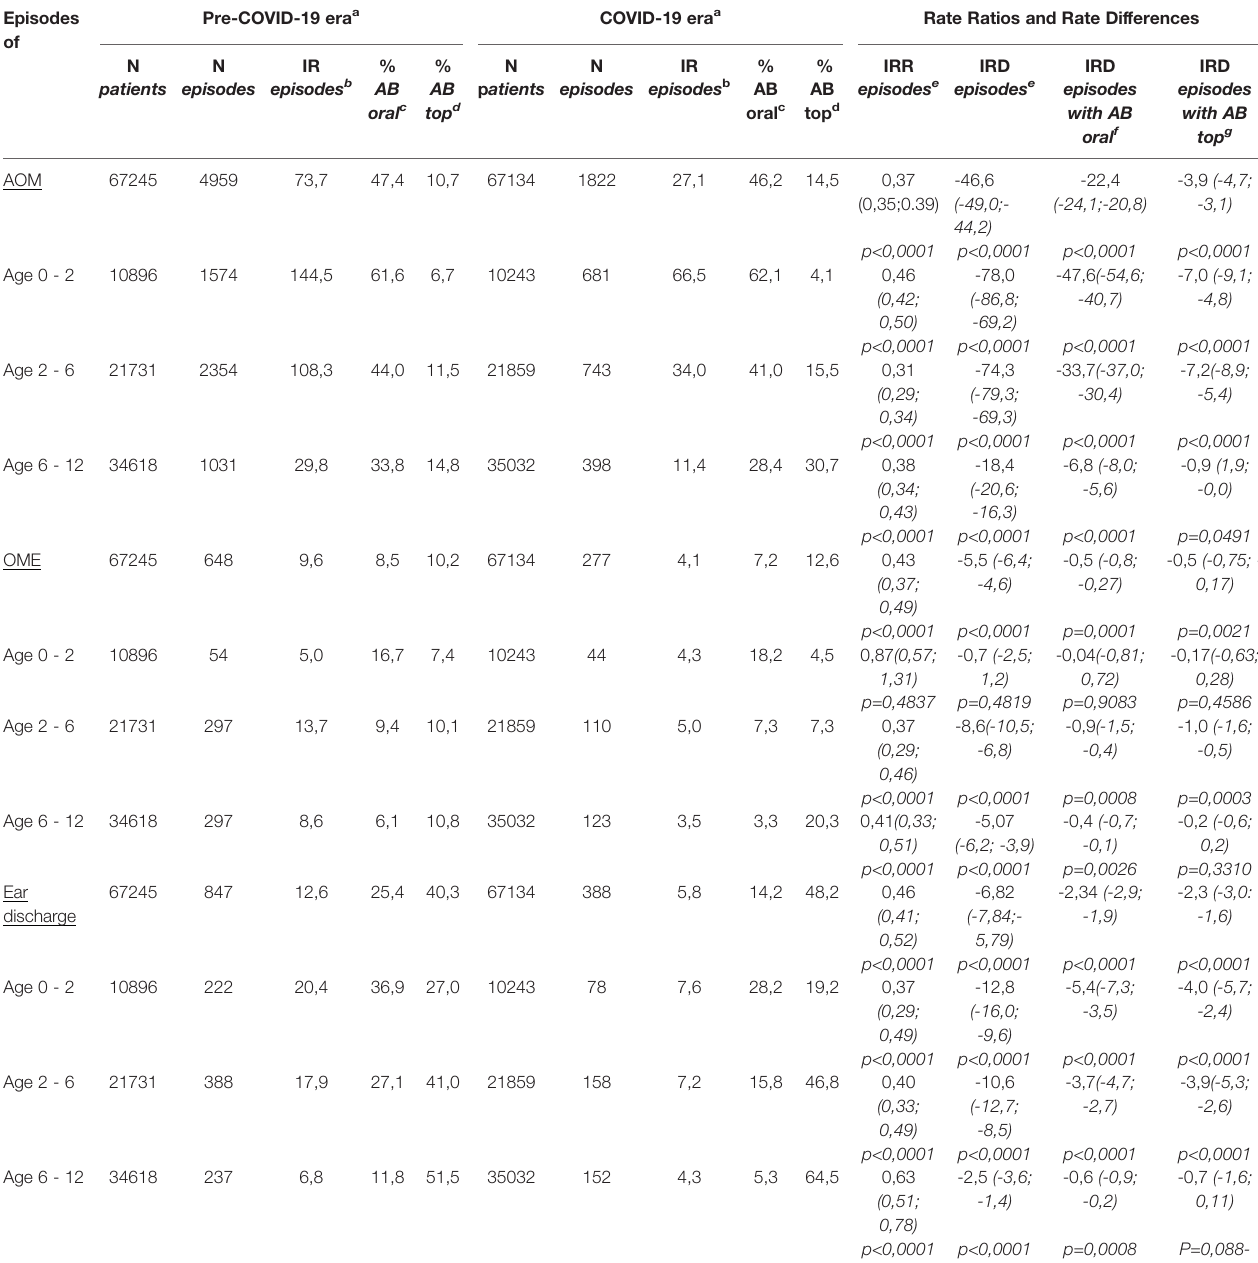
TABLE 1 | Number of Otitis media episodes and episodes with antibiotic prescription pre-COVID-19 era and COVID-19 era, including rate ratios and rate difference. Episodes Pre-COVID-19 era a COVID-19 era a Rate Ratios and Rate Differences of N